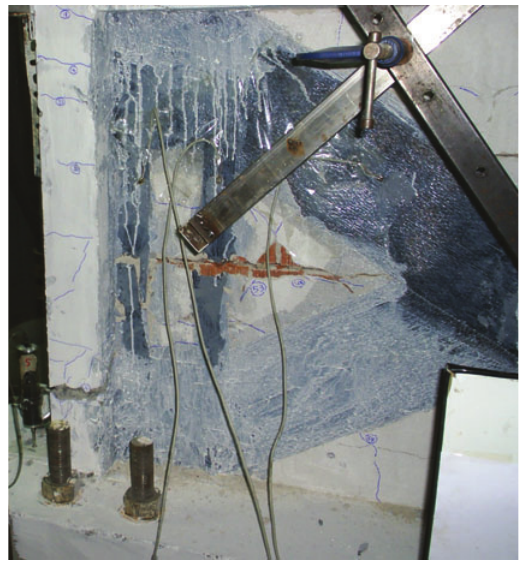
Figure 13 Damage state of specimen SA1.7-CVs at 0.86 % drift level.